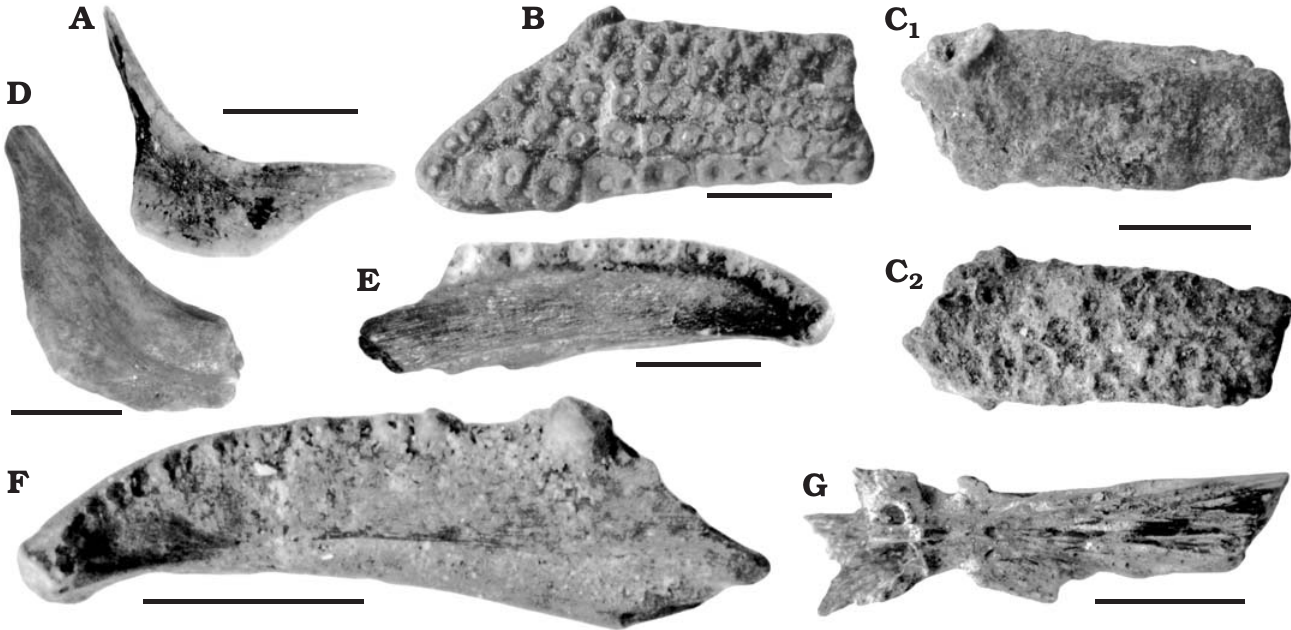
Fig. 5. Isolated elements assigned to the Northern Pike Esox lucius Linnaeus, 1758 from Southeastern Europe; Pleistocene. A . Left cleithrum (NMNHU-P 53/4249), Nova Etuliya, lateral view. B . Left palatine (NMNHU-P 53/4253), Semibalka 1, ventral view. C . Right palatine (NMNHU-P 53/4255), Medzhibozh, dorsal view (C 1 ), ventral view (C 2 ). D . Fragment of cleithra (NMNHU-P 53/4250), Sinyaya Balka, lateral view. E . Left dentary (NMNHU-P 53/4387), Semibalka 1, occlusal view. F . Right dentary (NMNHU-P 53/4264), Medzhibozh, occlusal view. G . Parashenoid (NMNHU-P 53/4254), Medzhibozh, dor- sal view. A, D, E, anterior to right; F, anterior to left; B, C, G, anterior towards top. Scale bars: A–F, 5 mm; G, 10